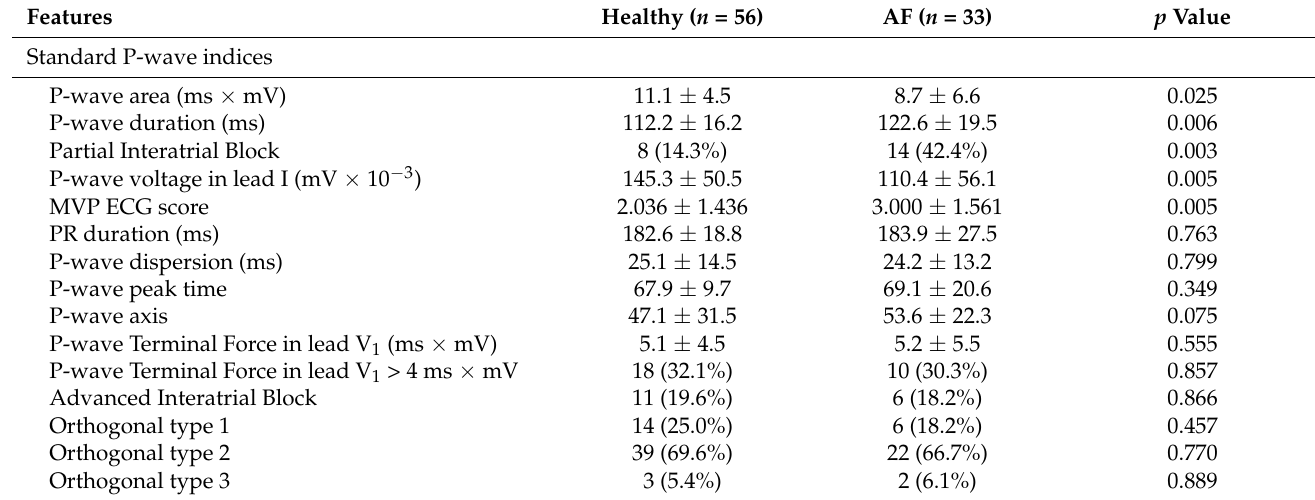
Table 3. P-wave indices and beat-to-beat variables in PAF patients and healthy